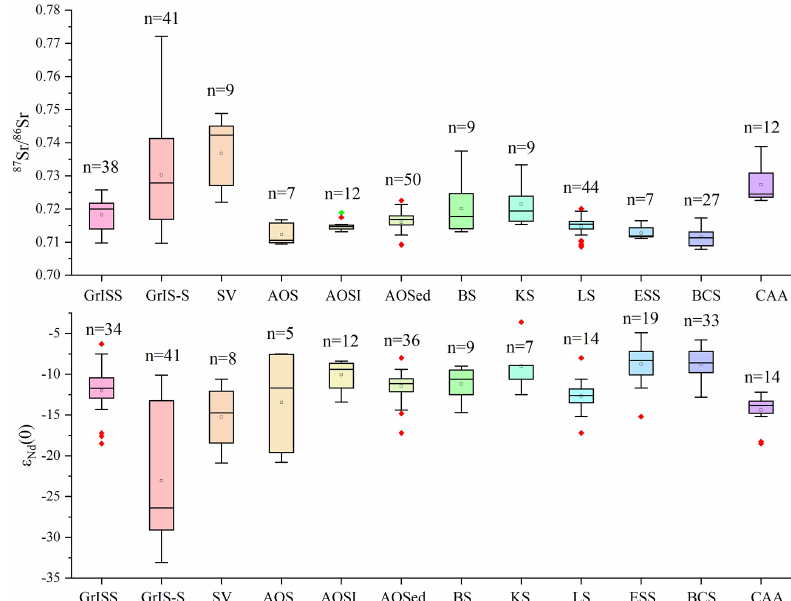
Figure 6. Box plot for the Sr–Nd isotopic signatures of the Arctic, including the 12 subregion samples of snow, sand, soil, and sediment from sea-ice and sediment cores in the dataset (the number of samples for each subregion is presented, n> 5). The abbreviations used in the figure are as follows: GrISS – Greenland ice sheet (snow samples), GrIS-S – Greenland ice sheet (sand), SV – Svalbard (snow and sand), AOS – Arctic Ocean (sediment), and AOSI – Arctic Ocean (sea-ice sediment).